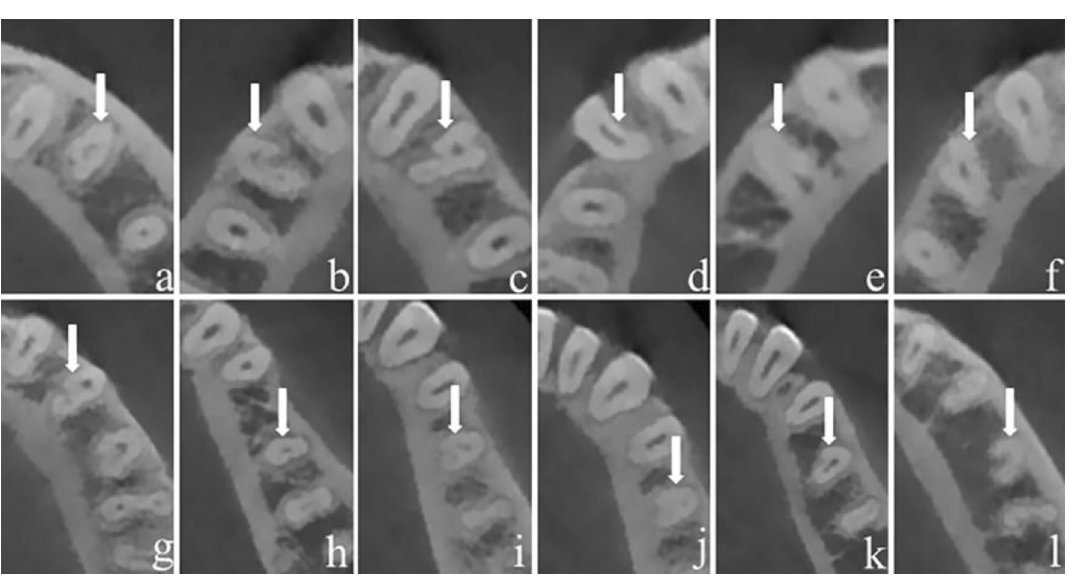
Figure 4. Different types of CSRCs and RGs in MFPs ( a , C1, Lingual; b , C2, ML; c , C3, ML and Buccal; d , C4, Mesial; e , C5, Lingual; f , C4, Buccal; g , C3, ML;) and MSPs ( h , C1, Distal; i , C2, Lingual; j , C3, Lingual; k , C4, ML; l , C5,